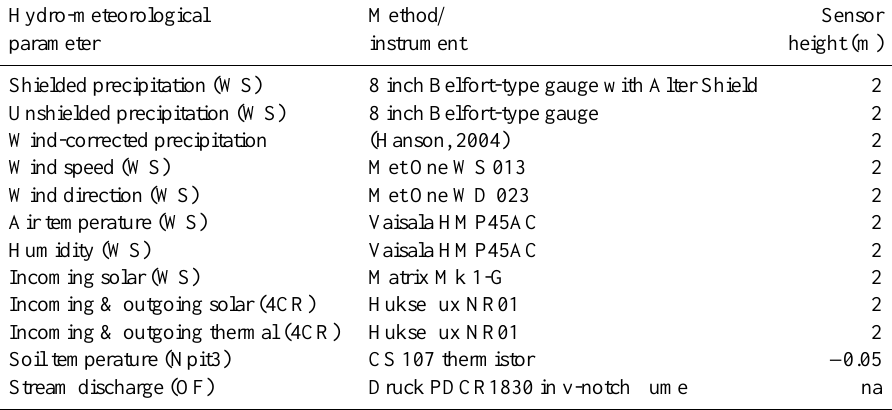
Table 1. Hydro-meteorological parameters, type of instruments, and instrument heights from the Treeline experimental catchment in WY2011. Locations are denoted by WS – weather station, 4CR – four component radiometer, Npit3 – north soil pit 3, OF – outlet flume.